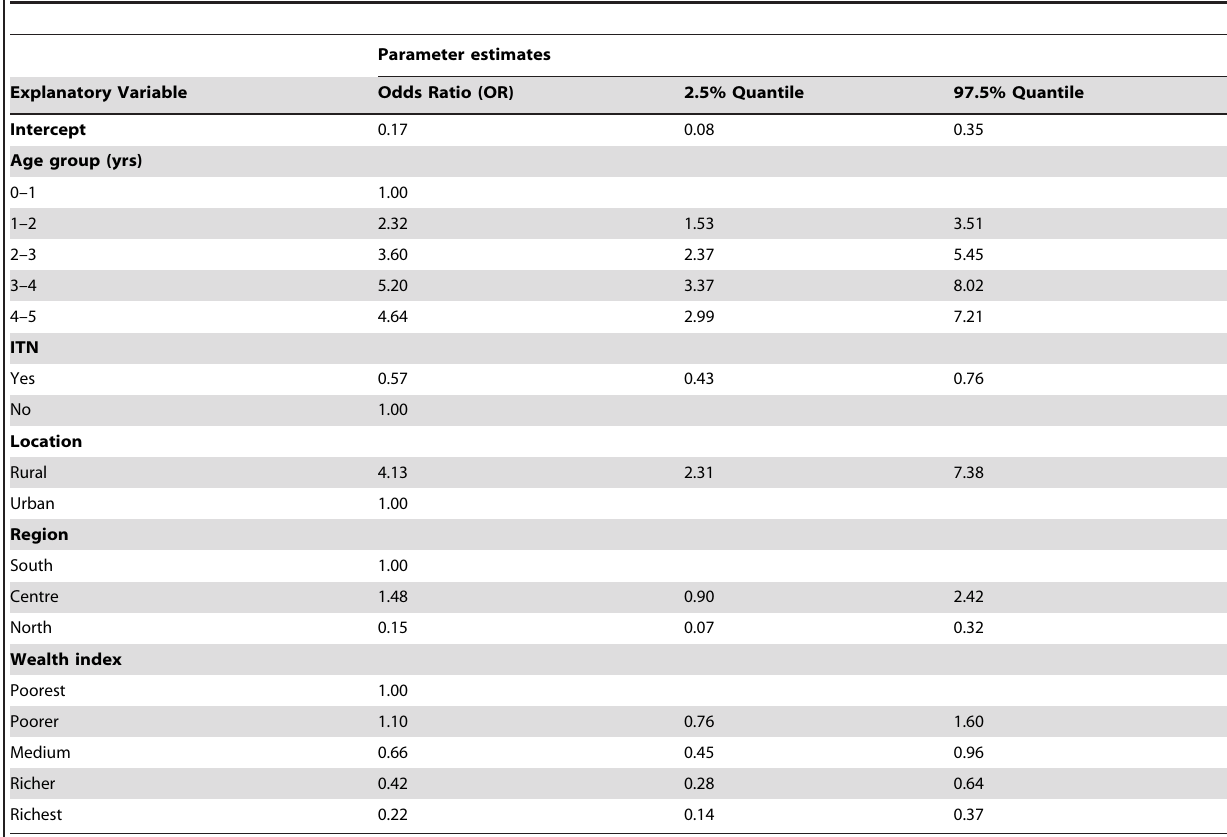
Table 3. Parameter estimates and 95% credible intervals for the categorical variables of the chosen